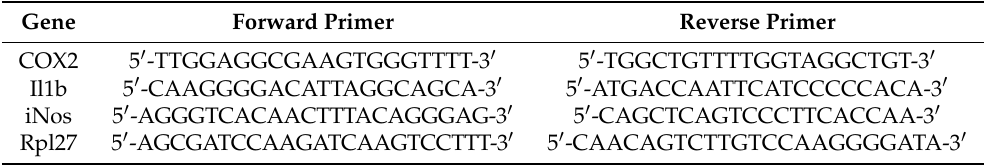
Table 1. Primer sequences used for gene amplification in the LPS-induced inflammation model.